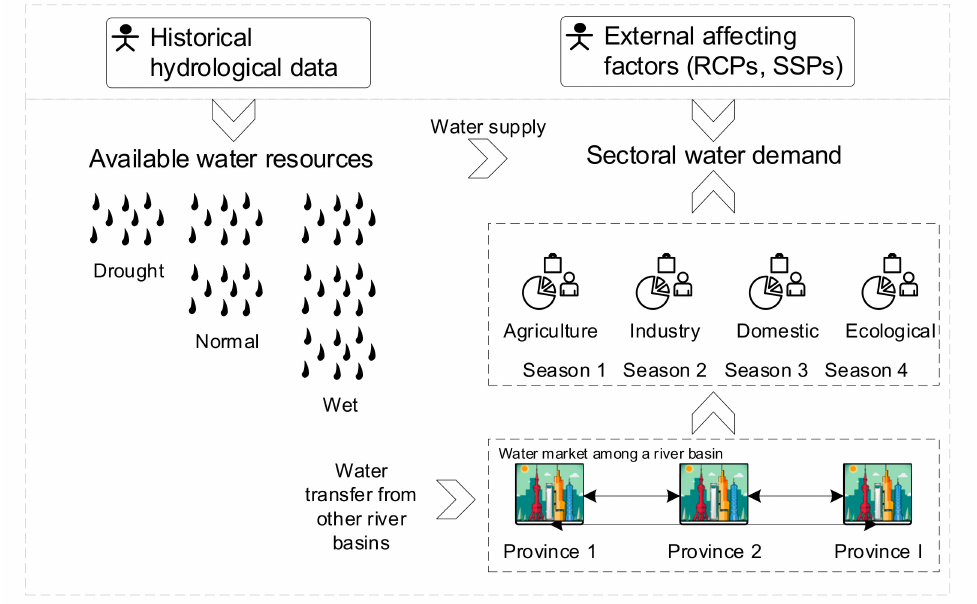
Figure 1. Water allocation framework with the presence of a water